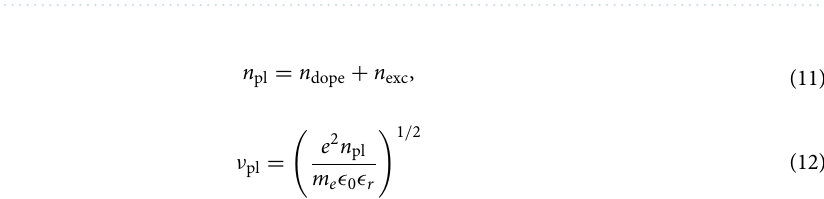
Figure 2. ( a ) Oscillatory components observed in the time reflectance variation of n -type GaAs semiconductors at each carrier density ( n exe ). The horizontal axis shows the time of measurement, and the vertical axis shows the signal strength. The signals are plotted vertically as a function of the carrier density. ( b ) Fourier spectrum of the time-resolved reflectivity change at each carrier density. The horizontal axis indicates the frequency, and the vertical axis indicates the intensity. The Fourier spectra are plotted vertically as a function of the carrier density as in ( a ). The dashed lines of the LB and UB curves in show the upper branch on the high- frequency side and lower branch on the low-frequency side, respectively, of the LOPC mode as calculated from the phenomenological effective Hamiltonian. The thin vertical dashed lines represent the frequencies of LO phonons at 8.7